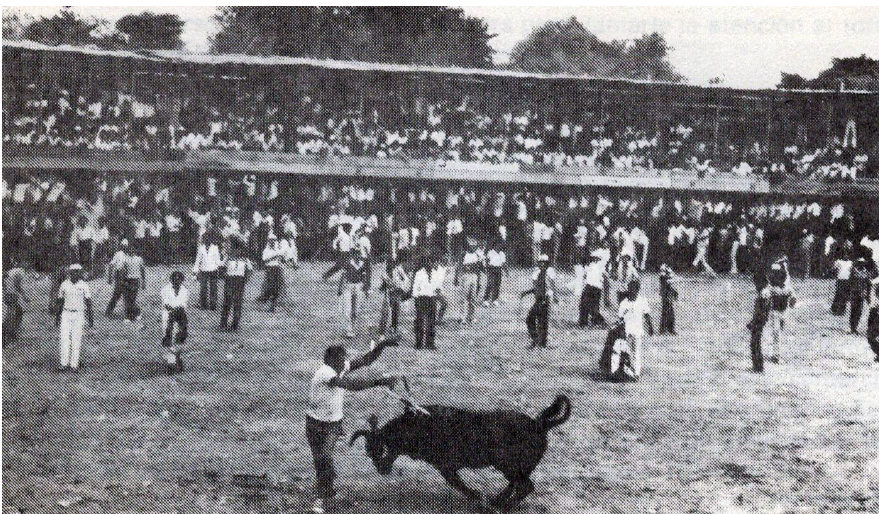
Figure 6. Old photograph showing elements of the Corraleja festival. Source: Santana Vega J.A (1986). in “El Mundo de La Corraleja”, editorial Graficas Corsa of Monteria, page 58 [9].